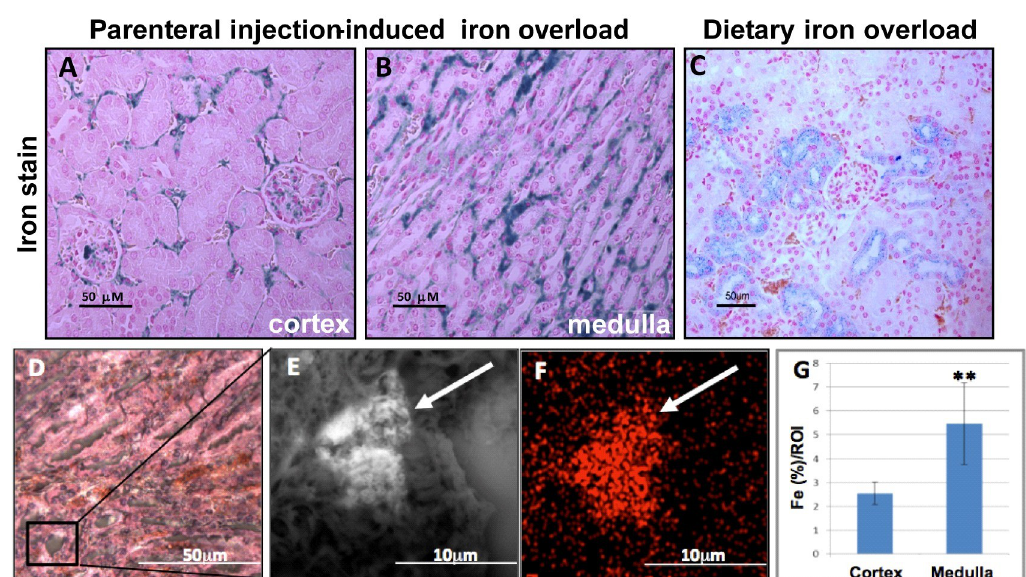
Fig 6. Iron accumulates in the kidney-interstitium of PIO mice. Fixed kidney sections from PIO mice (A-B and D-F) and from dietary iron overloaded mice (C) were stained and imaged. (A-C) Ferric iron was visualized with Prussian blue staining in cortex and medulla, respectively. In PIO mice, most iron accumulated in and around glomeruli and in the interstitium, and markedly little iron was detected in renal epithelial cells. In contrast, following dietary iron overload, most iron accumulated in proximal tubule epithelium of the cortex. (D) Light microscope; the black square indicates a sub-region of the medulla, which is enlarged in (E and F). (E) AirSEM analysis of the sub-region followed by EDX [Fe] mapping (F) indicated iron accumulation (marked with arrows) in the interstitium of the medulla. (G) Regions of interest in tubules and interstitium of cortex and medulla were selected and iron levels were quantified using airSEM. At least 2-fold increase of interstitial iron in the medulla compared to cortex was measured. �� P < 0.0001.